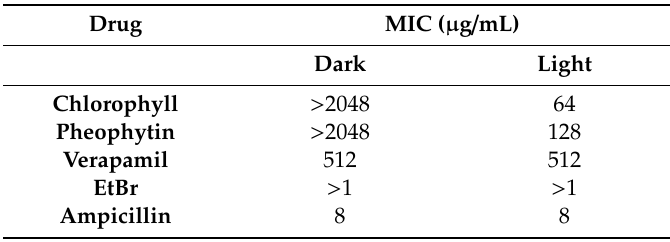
Table 3. Comparison of the minimum inhibitory concentrations (MICs) of chlorophyll and pheophytin when incubated with MRSA NCTC 10,442 in a dark and light environment. Drug MIC (µg/mL) Dark Light Chlorophyll >2048 64 Pheophytin >2048 128 Verapamil 512 512 EtBr >1 >1 Ampicillin